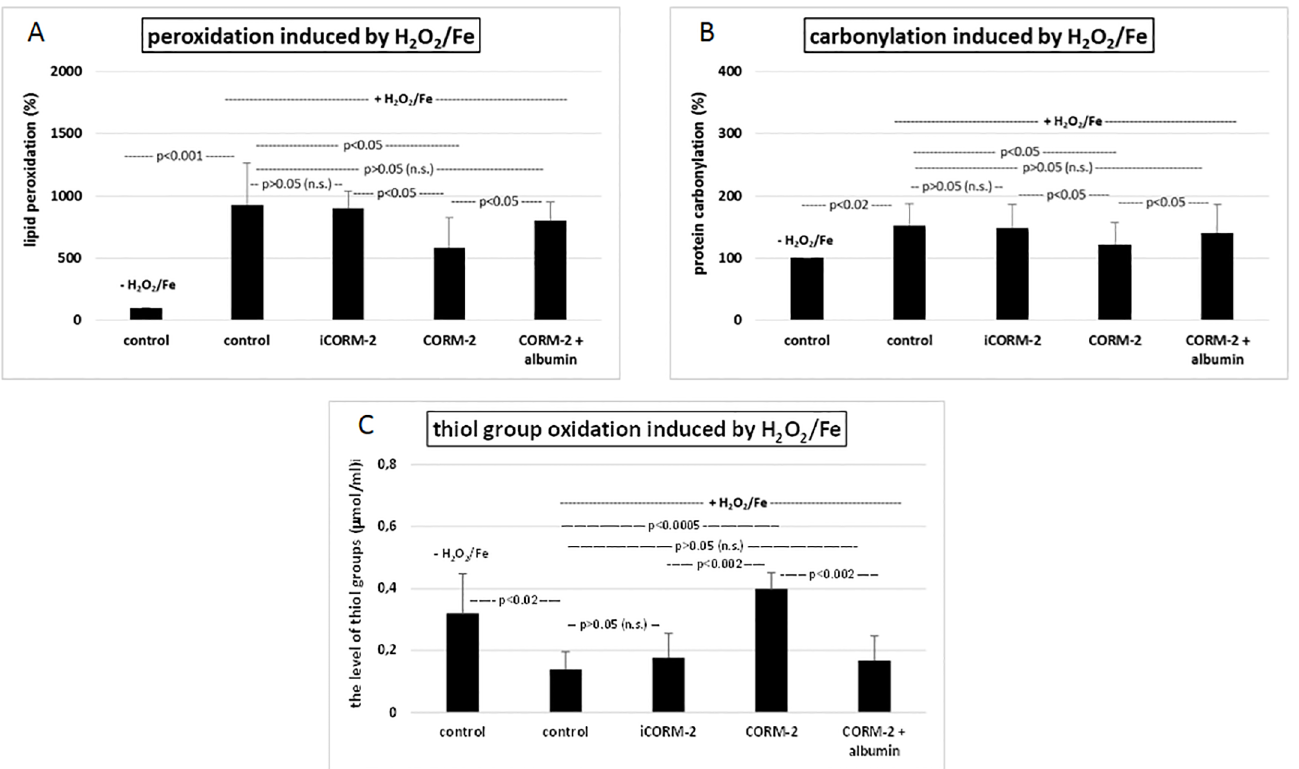
Fig 7. The effect of iCORM-2 (100 μ M, incubation time—30 min) or CORM-2 (100 μ M, incubation time—30 min) and albumin (10%, incubation time—30 min) on biomarkers of oxidative stress(lipid peroxidation (A), carbonyl group formation (B), oxidation of protein thiols (C)) in plasma treated with H 2 O 2 /Fe. Data represents means ± SD of 5–11 experiments (from different donors).